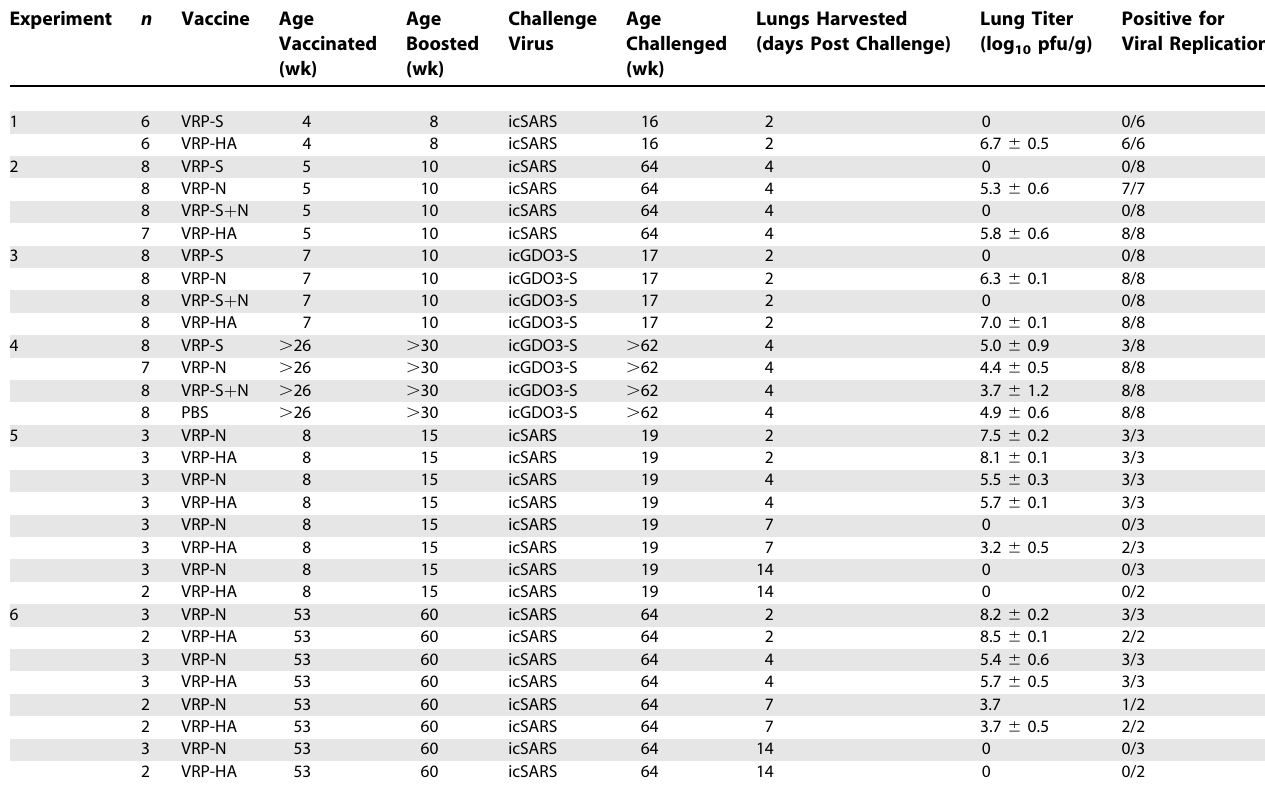
Table 1. Summary of Vaccine Groups and Select Results for Mouse Experiments Experiment